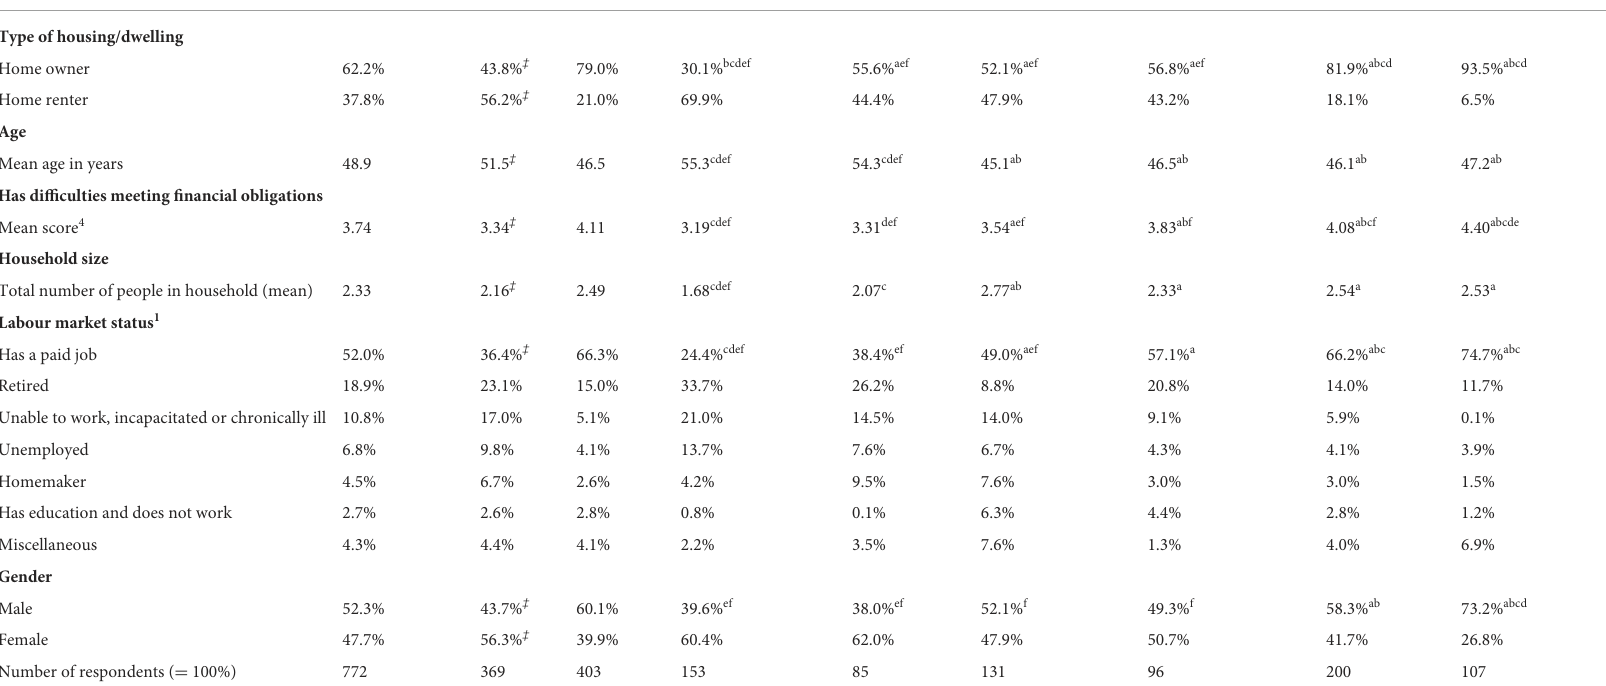
TABLE 2 Sample and SES groups’ socioeconomic and demographic